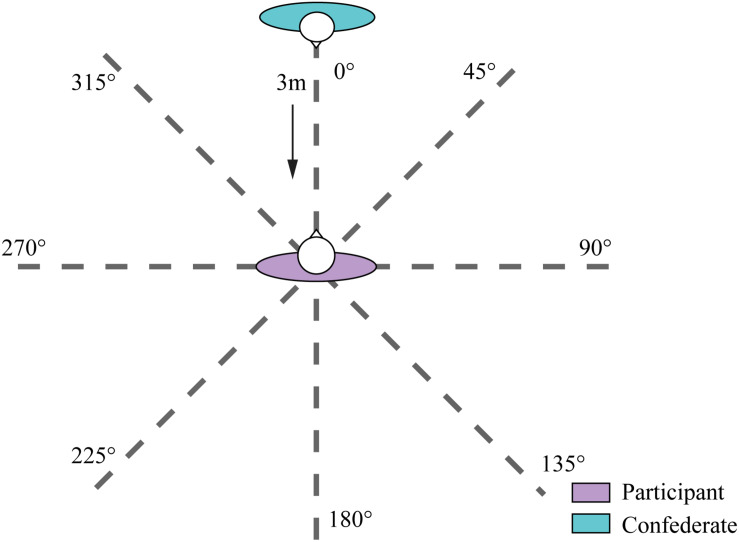
The experimental setting of this study.